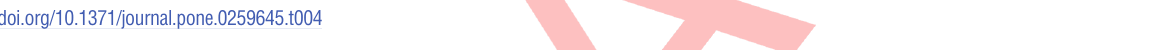
Table 5. Effect of tillage, cropping system, and soil depth on RC (g kg -1 ) in different sites of Malda and Coochbehar districts. District Malda Coochbehar